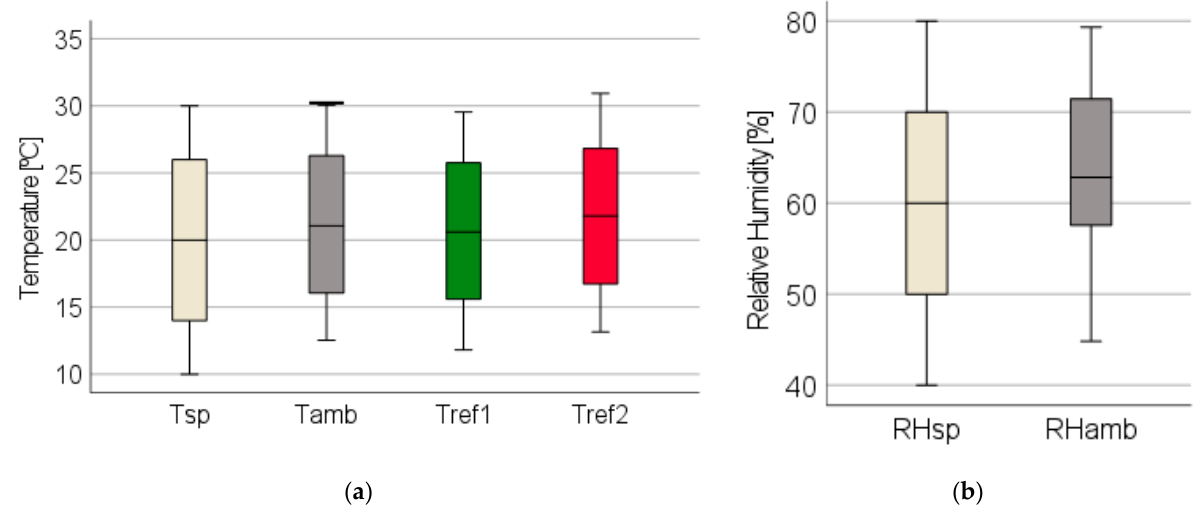
Figure 6. Box plots representations of ( a ) temperature and ( b ) relative